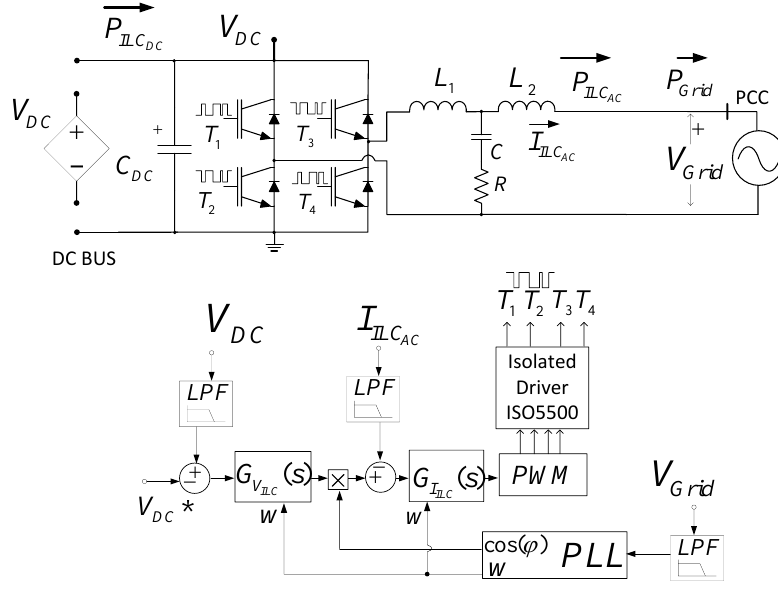
Figure 4. Topology and control diagram of the ILC.